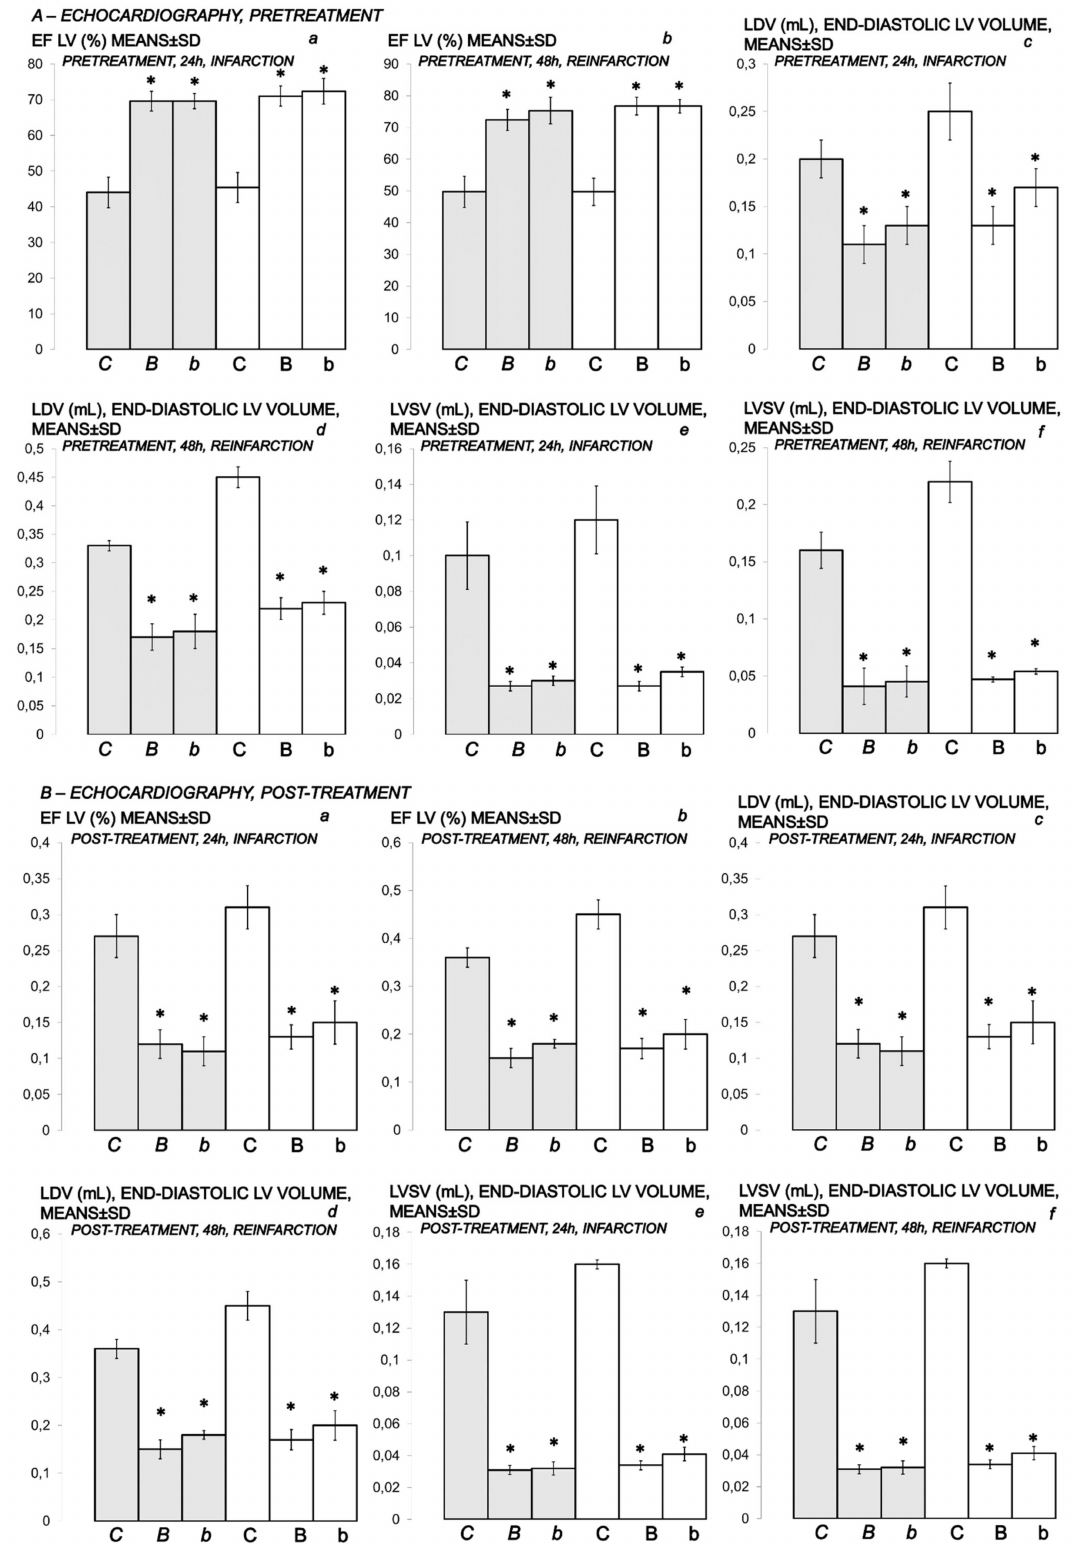
Figure 18. ( A , B ) Myocardial infarction (1 isoprenaline challenge) and re-infarction (2 isopre- naline subsequent challenges) in isoprenaline-rats (75 mg/kg sc (gray bars), 150 mg/kg sc (white bars)). Gross heart lesions presentation. A–ECHOCARDIOGRAPHY, PRETREATMENT; B–ECHOCARDIOGRAPHY, POST-TREATMENT. Isoprenaline-rats treated with the smaller